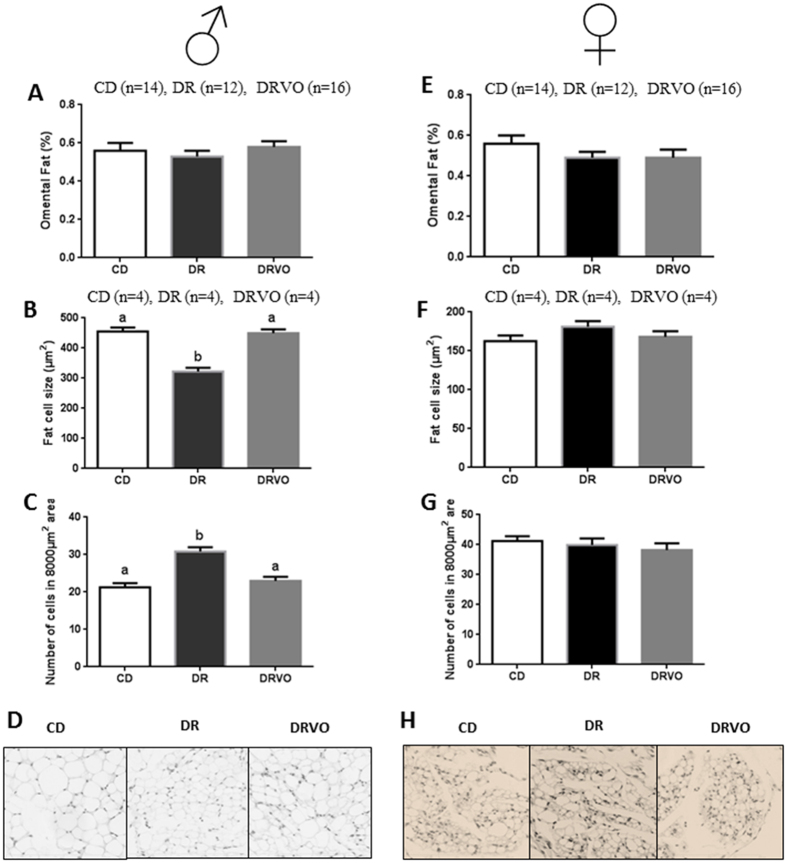
Vitamin and antioxidant supplementation of under nourished fathers restores male offspring adipocyte number and size.(A) Male offspring omental fat as a percentage of total body weight at 15 weeks. (B) Male offspring adipocyte cell size of omental fat at 15 weeks. (C) Male offspring adipocyte cell number at 15 weeks. (D) Male offspring omental fat cell size representative pictures for each founder treatment (40x). (E) Female offspring omental fat as a percentage of total body weight at 15 week PM. (F) Female offspring fat cell size of omental fat at 15 weeks. (G) Female offspring fat cell number at 15 weeks (H) Female offspring omental fat cell size representative pictures for each founder treatment (40x). Omental fat percent of total body weight represents 14 females and 14 males from 7 litters generated from 6 founders for CD group, 12 females and 12 males from 6 litters generated from 6 founders for DR group, and 16 females and 16 males from 8 litters generated from 8 founders for the DRVO group. Adipocyte number and size represents 4 males and 4 females from 4 litters generated from 4 founders for each treatment group. Statistical significance was determined with a general linear mixed model, with founder ID added as a random factor to adjust outcomes for offspring generated from the same founder. Data is expressed as mean ± SEM. Different letters denote significance at P < 0.05.